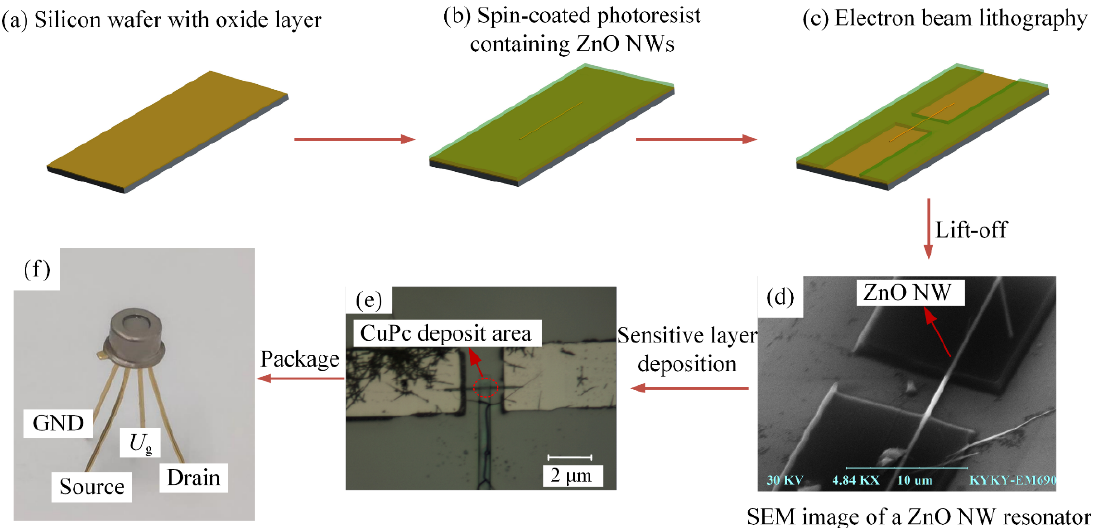
Figure 2. Fabrication process of the ZnO nanowire